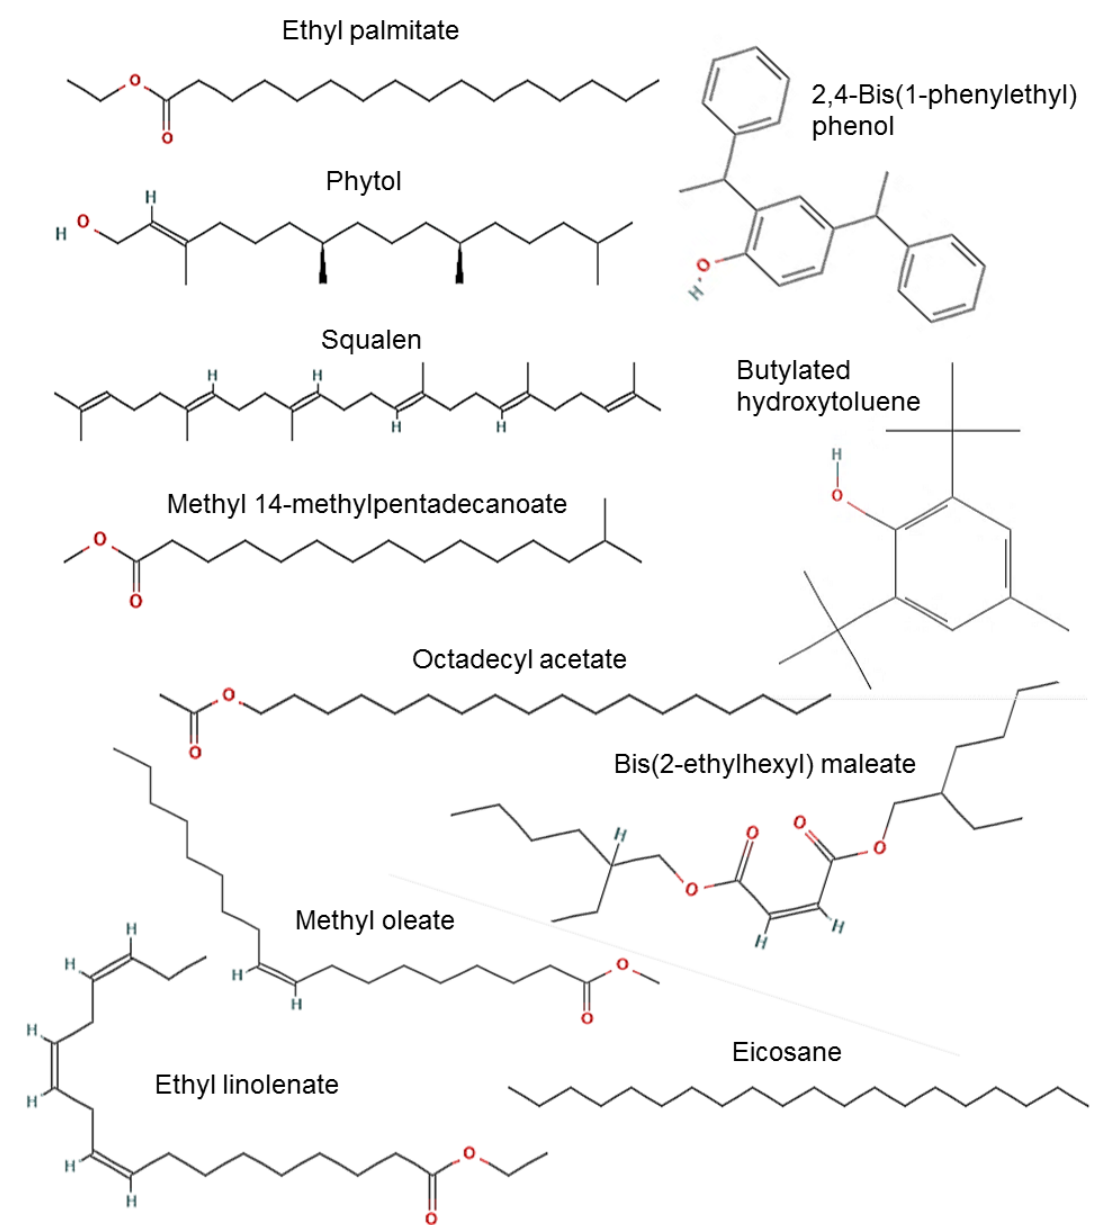
Figure 2 . Structure of the most abundant molecules in the P. alliacea L. leaves . Figure 2. Structure of the most abundant molecules in the P. alliacea L.